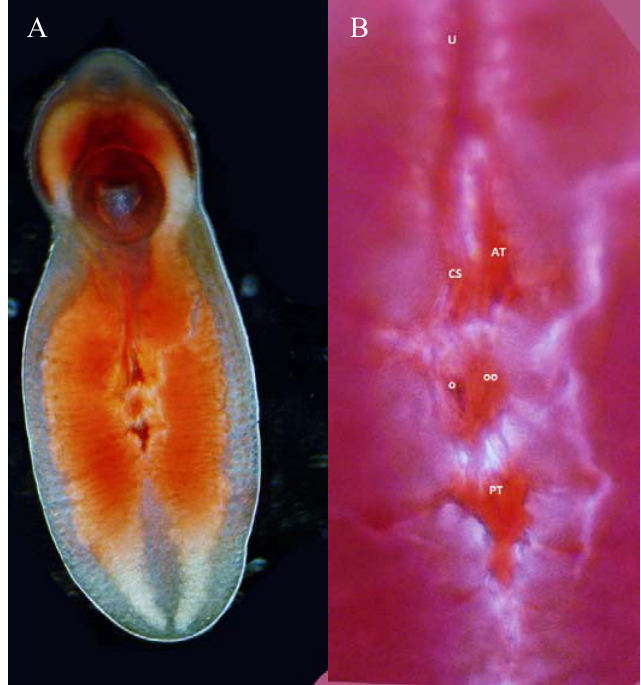
F IGURE 3. Image of Clinostomum complanatum metacercariae, A. whole worm, B. genital complex. AT: anterior testis, CS: cirrus sac, O: ovary, OO: ootype, PT: posterior testis.